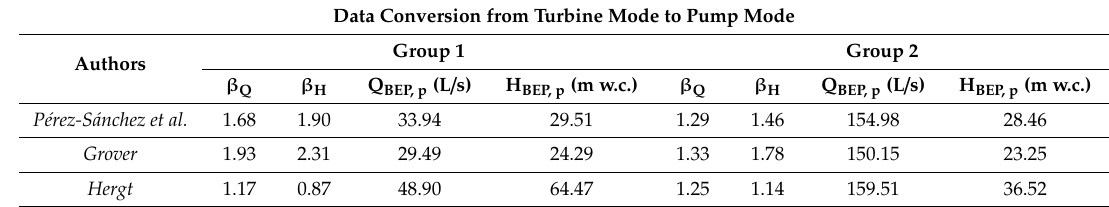
Table 11. Data conversion from turbine mode to pump mode (point #7).